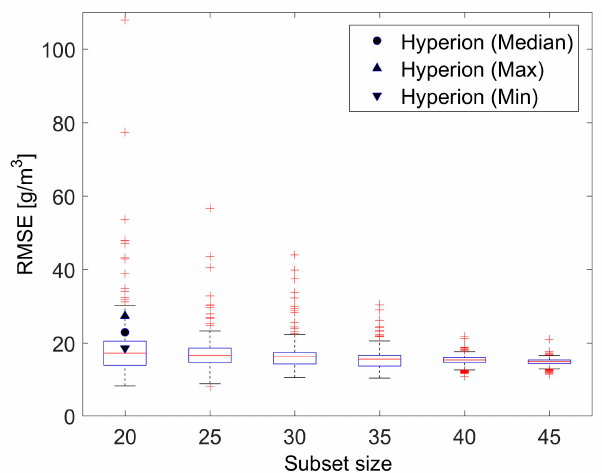
Figure 9. Validation of RTM-inversion method (Equation (8)) using different subset size of multispectral data (total of 52). In the box-whisker plots, the red central line is the median, the edges of the box are the 25th and 75th percentiles, the whiskers extend to the extreme data points within approximately ±2.7 standard deviation from the mean (covering 99.3% data), and outliers are plotted as red crosses. For comparison, the median, max, and min RMSE estimated using the Hyperion data (total of 20) with two spectral bands are also plotted (black dot and arrows).